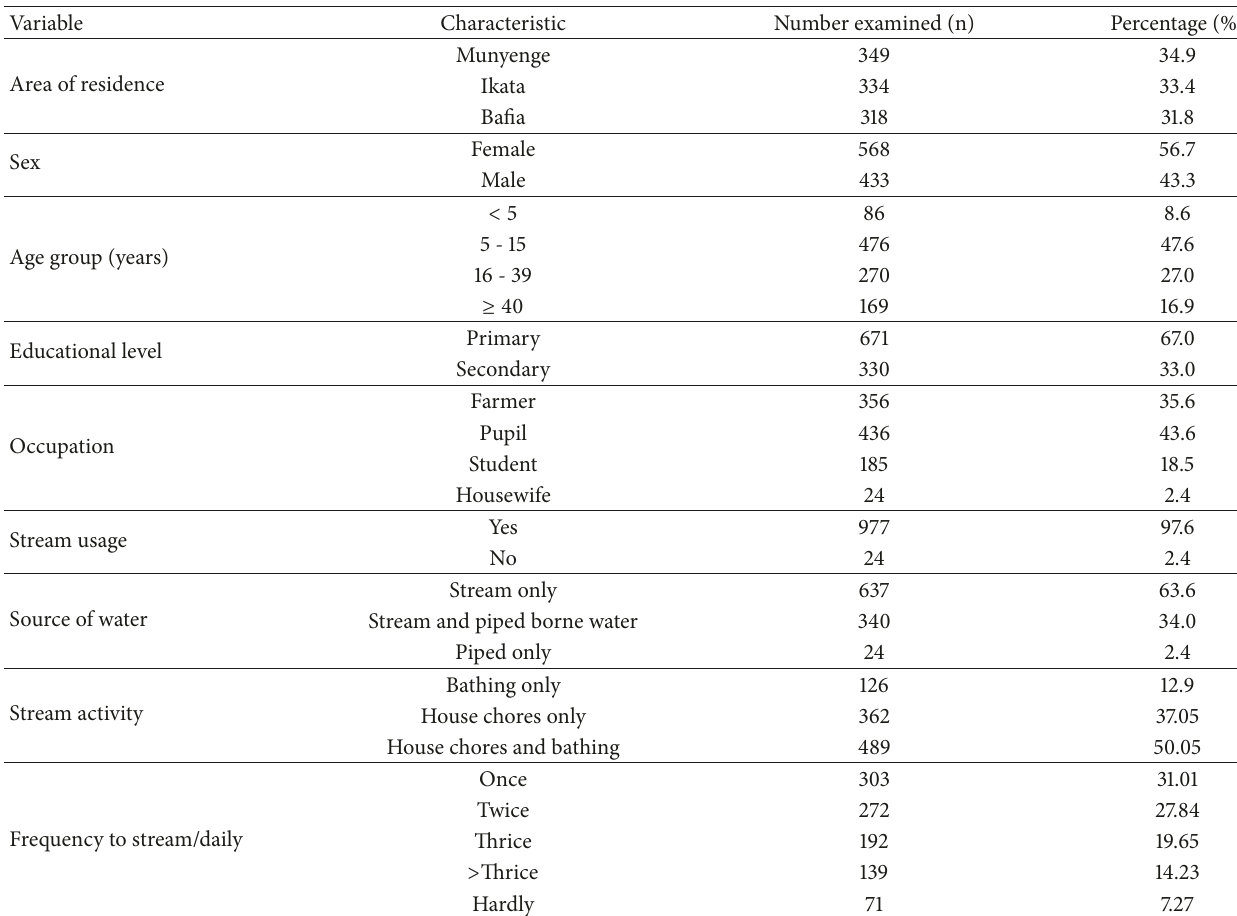
Table 1: Sociodemographic characteristics of the study